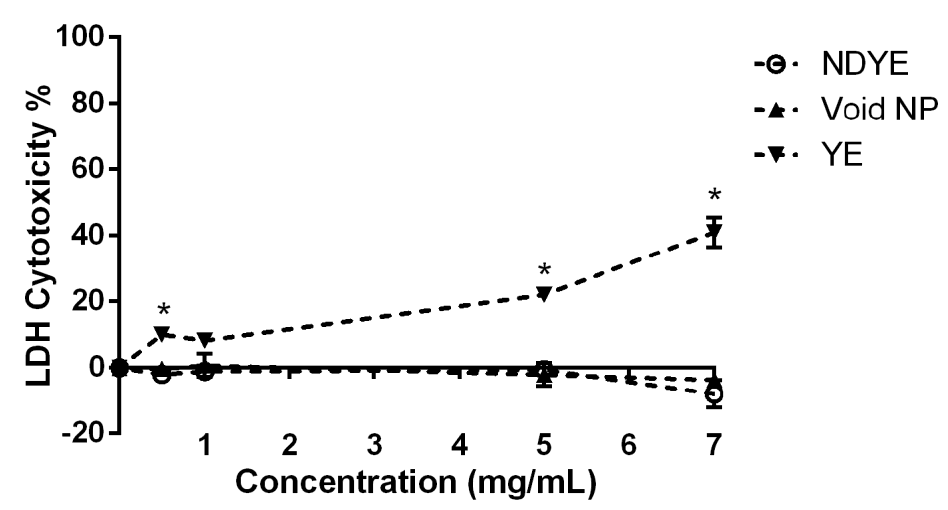
Figure 3. Evaluation of the effect of NDYE ( ○ ), void NPs ( ▼ ) and yellow everzol ( ▲ ) upon HaCat cell wall integrity, at the different concentrations tested. * Represents the statistically significant differences ( p < 0.05) found between the textile dye and the tested nanoparticles.